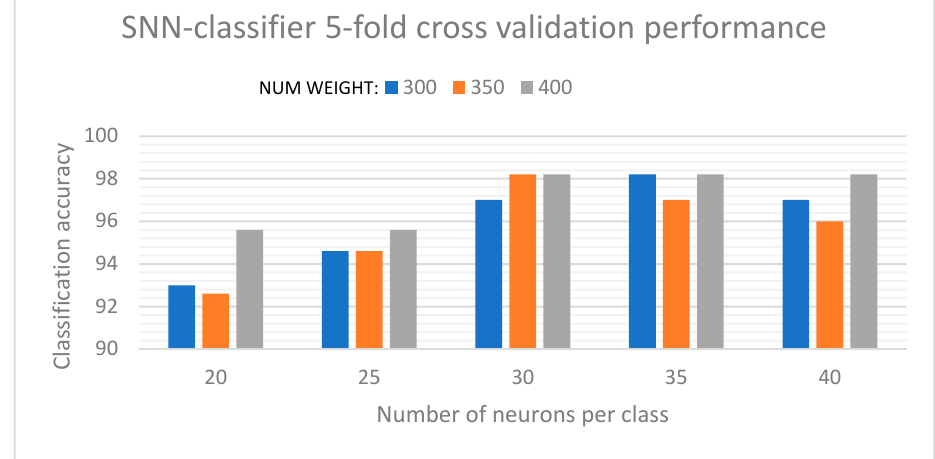
Figure 8. SNN-classifier performance for the 20-class dataset .